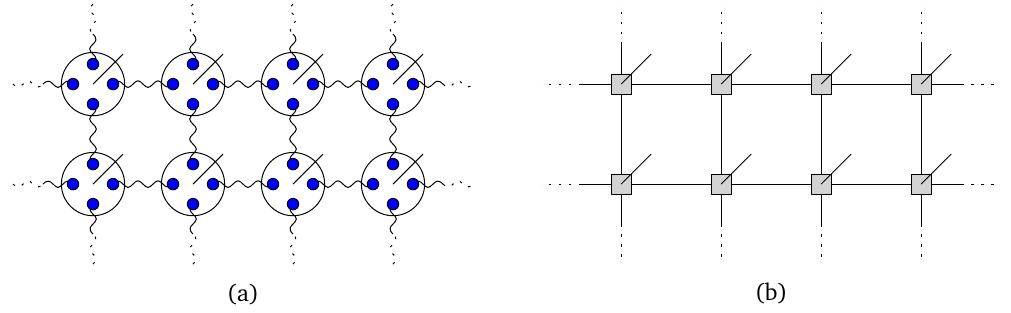
Figure 6: (a) A 2 × 4 patch of a 2-dimensional PEPS lattice, with the physical index drawn as sticking out up and to the right. (b) The same patch with more general